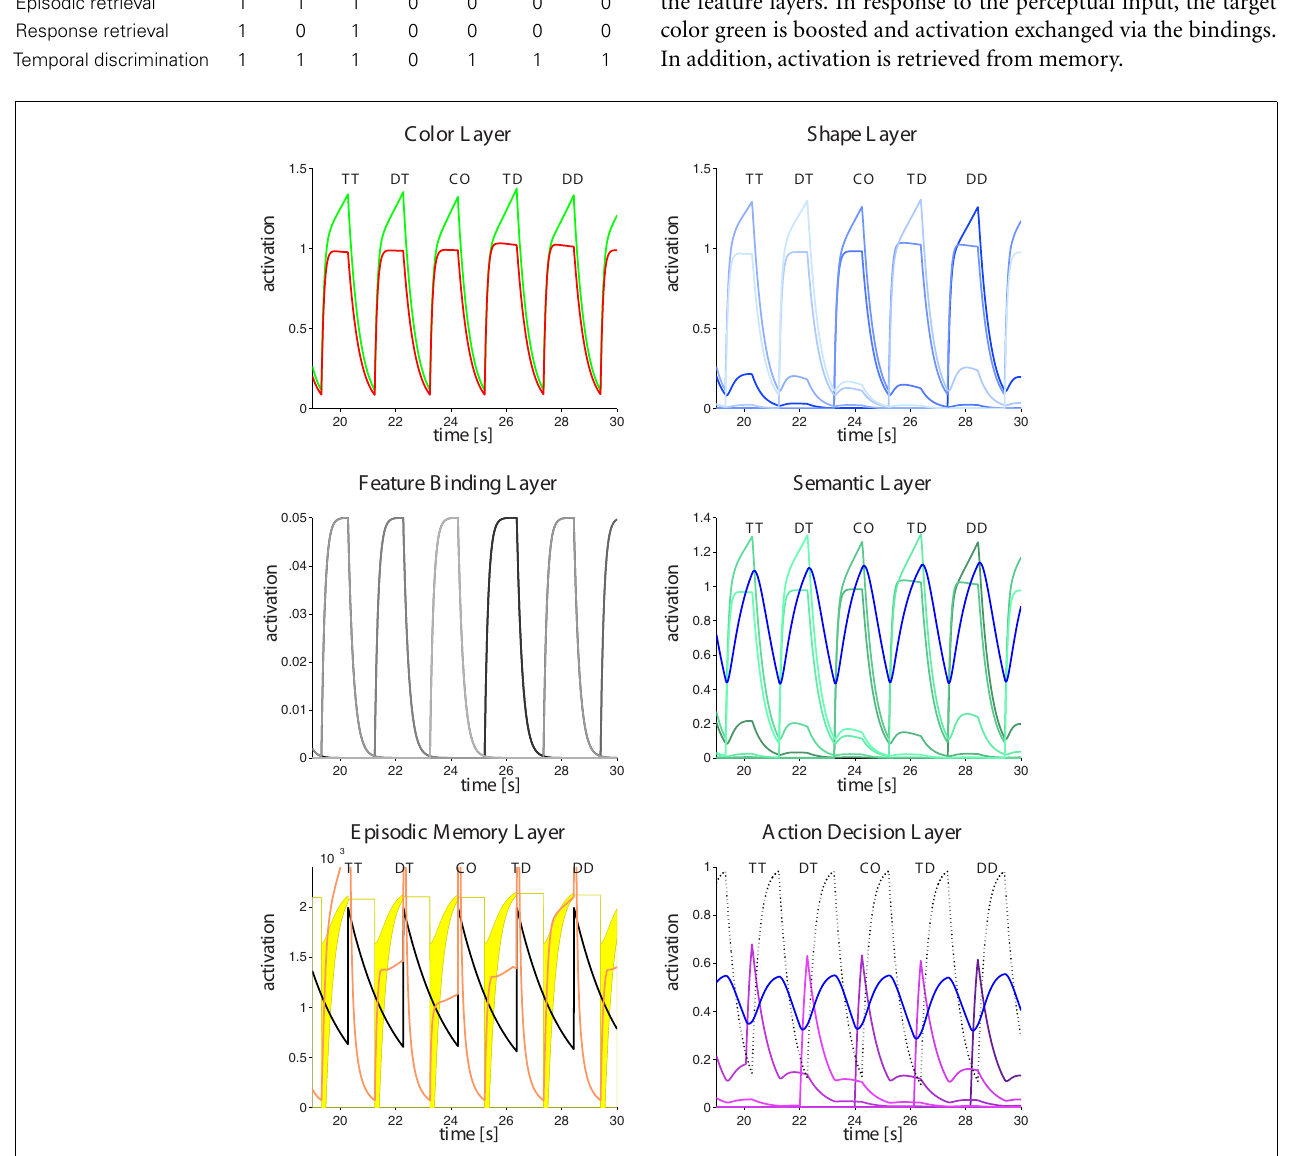
layer denotes the strength of the memory trace, yellow is the uncertainty region for the old-new signal which is drawn in orange.The model is in classical episodic-retrieval mode, see Section 3.1.Targets are boosted and the entire episode retrieved. Retrieval is apparent in the plots by the re-rise of formerly active